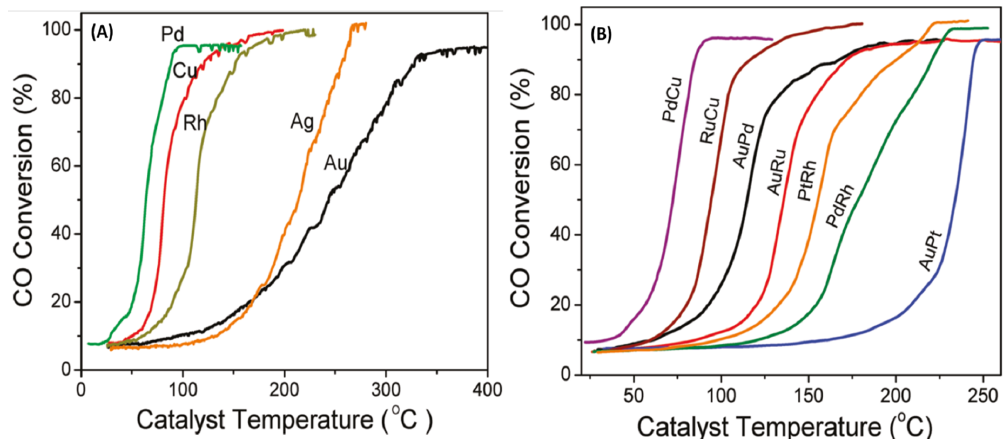
Figure 8. CO oxidation behavior of different metals ( A ) and bimetallic alloy NPs ( B ) supported on CeO 2 NPs. Adapted with permission from the American Chemical Society. Copyright 2009 American Chemical Society.